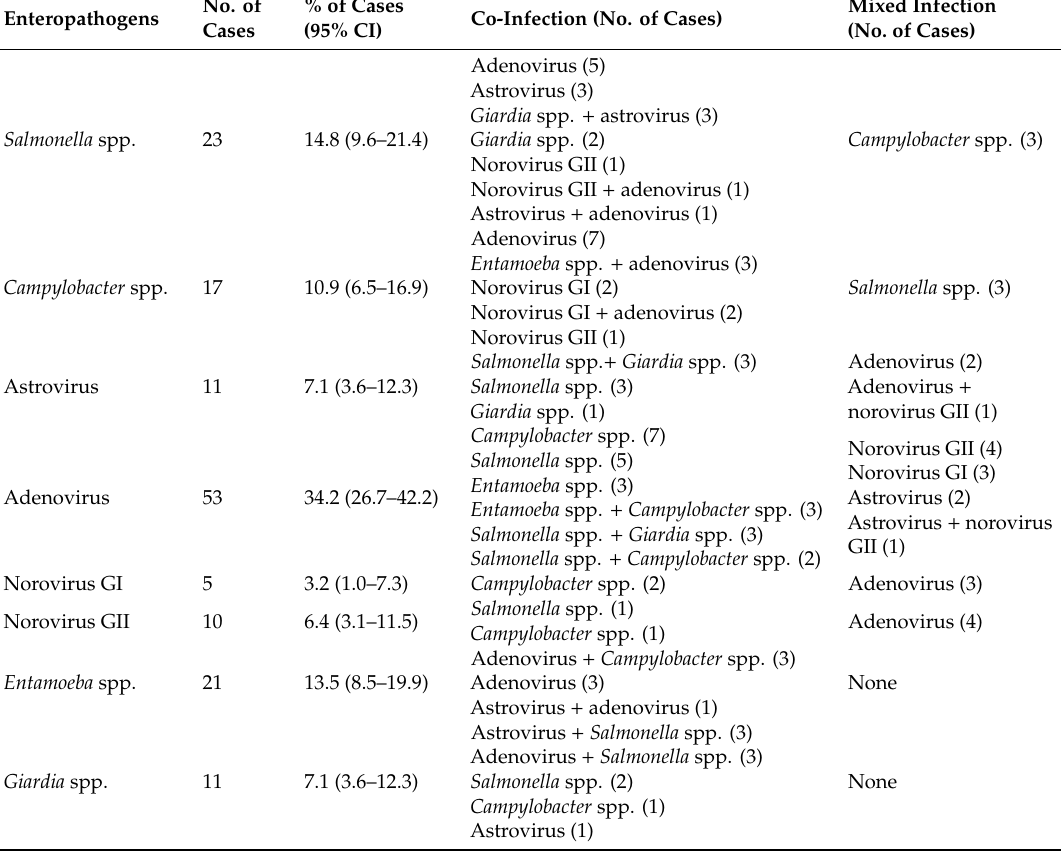
Table 3. Frequency of isolation, co-infection, and mixed infection patterns of enteropathogens detected in diarrheal cases ( n = 155) among children < 5 years. CI—confidence